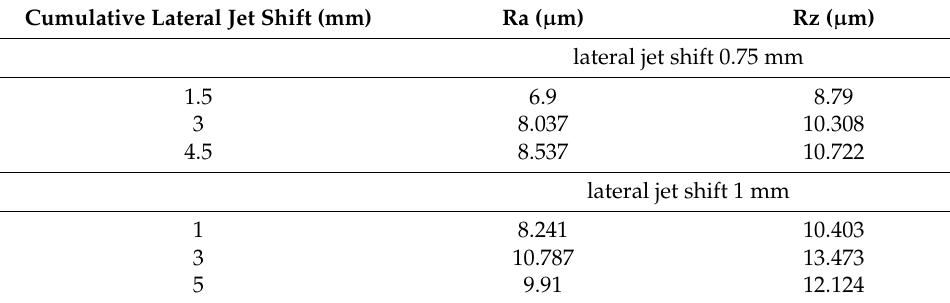
Table 12. Roughness of the specimen for certain cumulative lateral jet